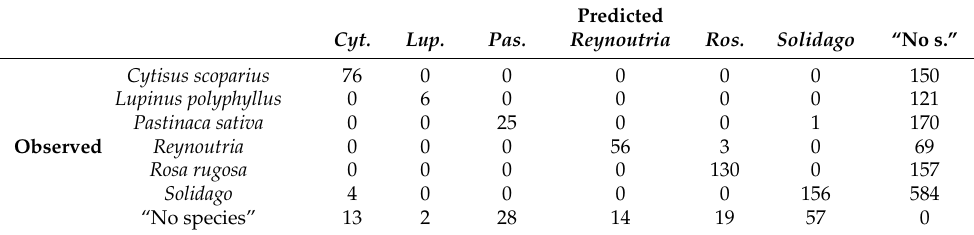
Table 5. Confusion matrix of the YOLOv3 model predictions on the test dataset with a confidence threshold of 25%. The matrix shows the number of predicted species compared to the observed annotated species.